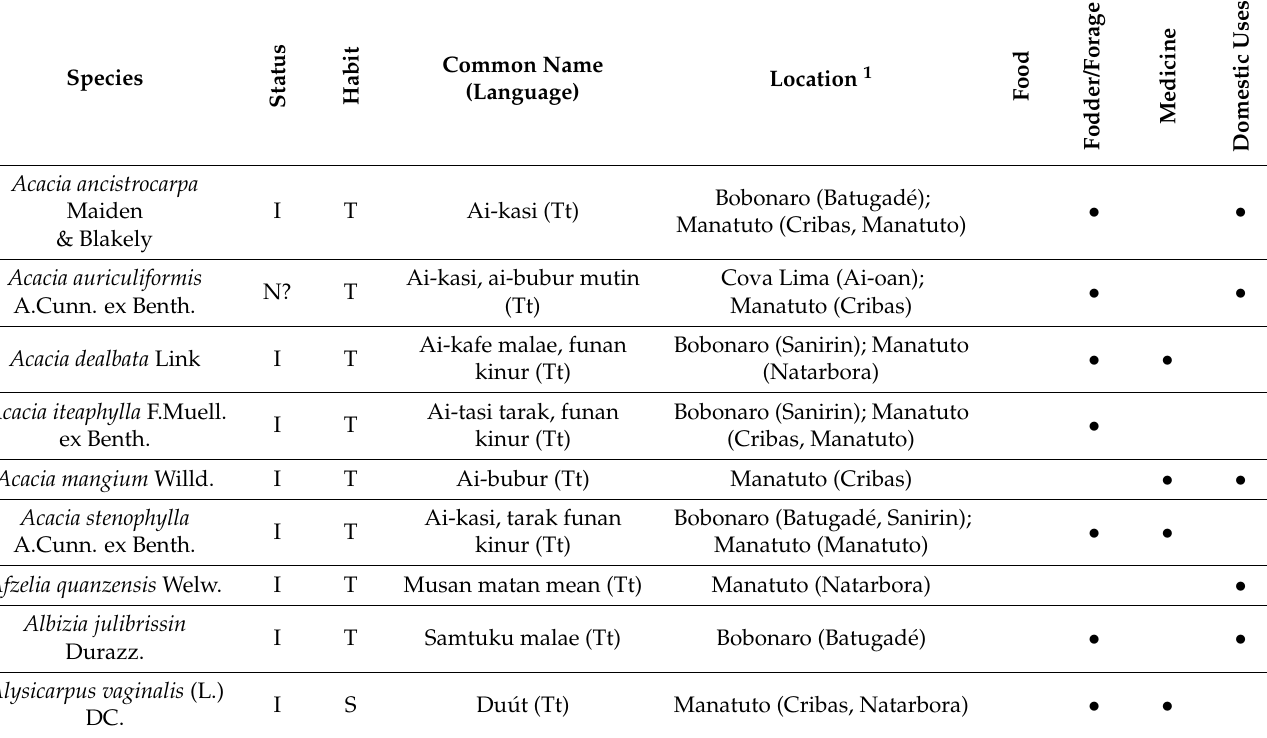
Table 2. Legume species present in cashew agroforestry systems of East Timor. For each species: provenance (I—introduced; N—native), habit (T—tree; S—shrub or subshrub; C—climber), common names (Mc, Macassae—indigenous language of Baucau; Km, Kemak—indigenous language of Bobonaro; Tt, Tetum; Ml, Malayu), surveyed location; and main